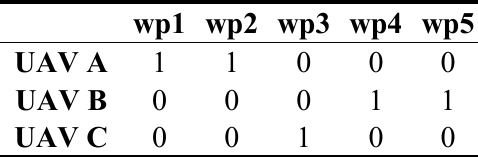
Table 1. Initial Task Allocation